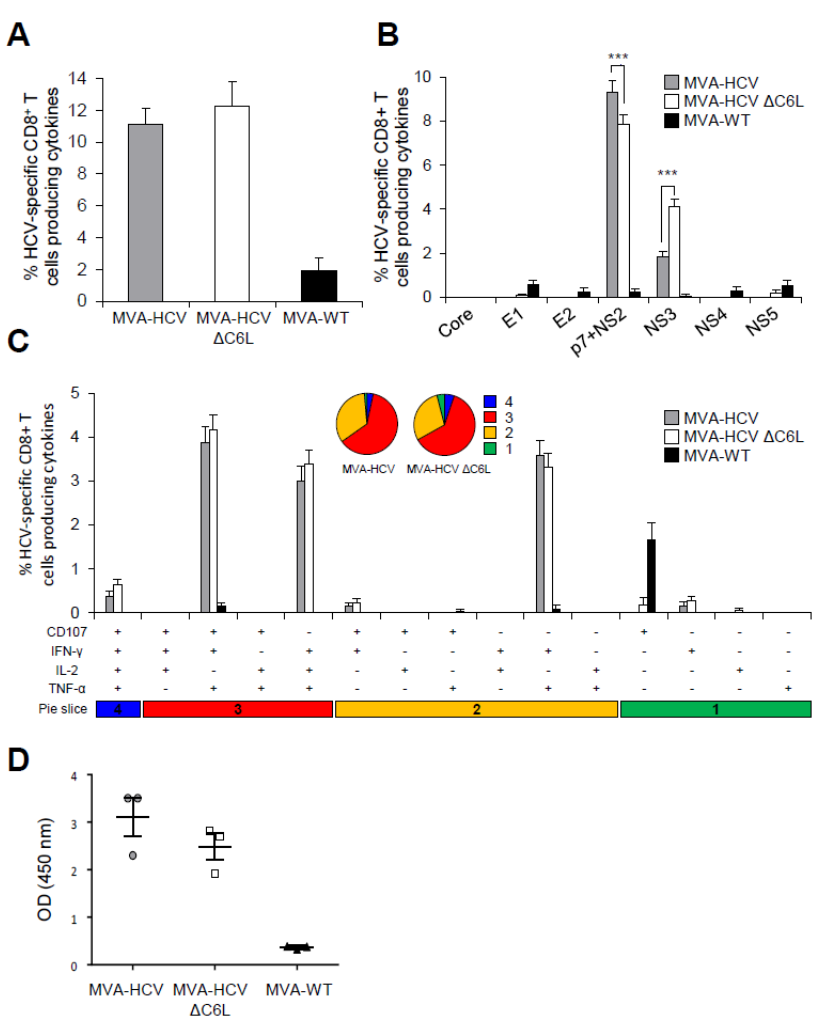
Figure 5. HCV-specific T cell and humoral adaptive immune responses induced in immunized mice. Splenocytes were obtained from mice ( n = 4 per group) immunized with two doses of MVA-WT, MVA-HCV, or MVA-HCV ∆ C6L 10 days after the last immunization. Then, HCV-specific CD8 + T cell adaptive immune responses elicited were measured by intracellular cytokine staining (ICS) after stimulation of splenocytes with different HCV peptide pools. Values from unstimulated controls were subtracted in all cases. p values indicate significantly response differences when comparing MVA-HCV with MVA-HCV ∆ C6L (*** = p ≤ 0.001). Data is from one experiment representative of four independent experiments. ( A ) Magnitude of total HCV-specific CD8 + T cell adaptive immune responses directed against HCV antigens. The values represent the sum of the percentages of CD8 + T cells producing CD107a and/or IFN- γ and/or TNF- α and/or IL-2 against Core, E1, E2, p7 + NS2, NS3, NS4, and NS5 peptide pools. ( B ) Percentages of Core, E1, E2, p7 + NS2, NS3, NS4, or NS5 HCV-specific CD8 + T cells. Frequencies represent the sum of the percentages of CD8 + T cells producing CD107a and/or IFN- γ and/or TNF- α and/or IL-2 against each HCV peptide pool. ( C ) Polyfunctionality profile of total HCV-specific CD8 + T cell adaptive immune responses directed against HCV antigens and producing CD107a and/or IFN- γ and/or TNF- α and/or IL-2. Responses are grouped and color coded, taking into consideration the number of functions (one, two, three, or four). ( D ) Humoral immune responses induced by MVA-WT, MVA-HCV, and MVA-HCV ∆ C6L against HCV E2 protein. Levels of E2-specific total IgG binding antibodies were measured by ELISA in serum from individually mice immunized with two doses of MVA-WT, MVA-HCV, or MVA-HCV ∆ C6L at day 10 after the last immunization. Absorbance values (measured at 450 nm) correspond to 1/100 dilution of individual serum, and each mouse is represented by a dot. The mean ± SD are